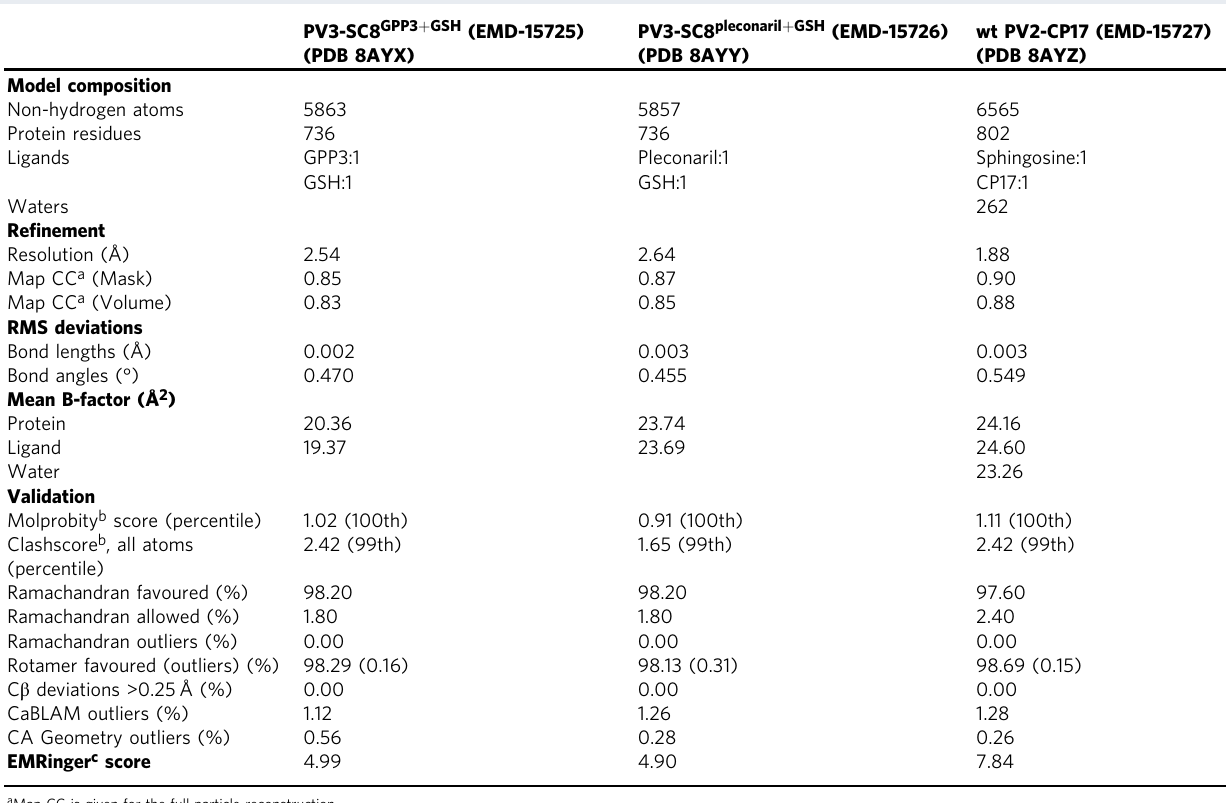
Table 2 Structure re fi nement and validation for the capsid protein (VP0, VP1 and